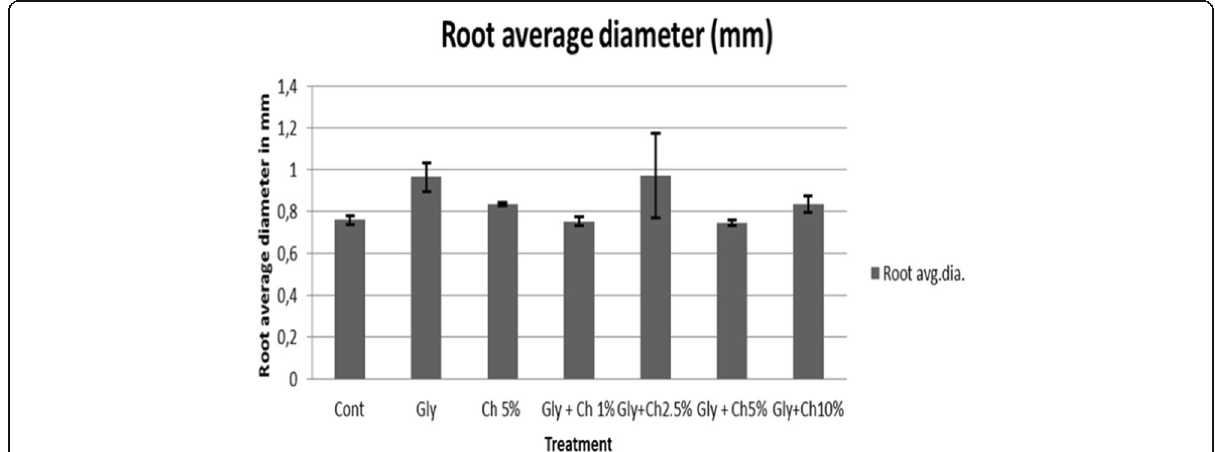
Fig. 8 Root average diameter of winter wheat seedlings (cv. Isengrain) of different treatments 14 days after seeding. Data show average treatment values of four independent replicates. Data show average treatment values of four independent replicates. Error bars indicating standard